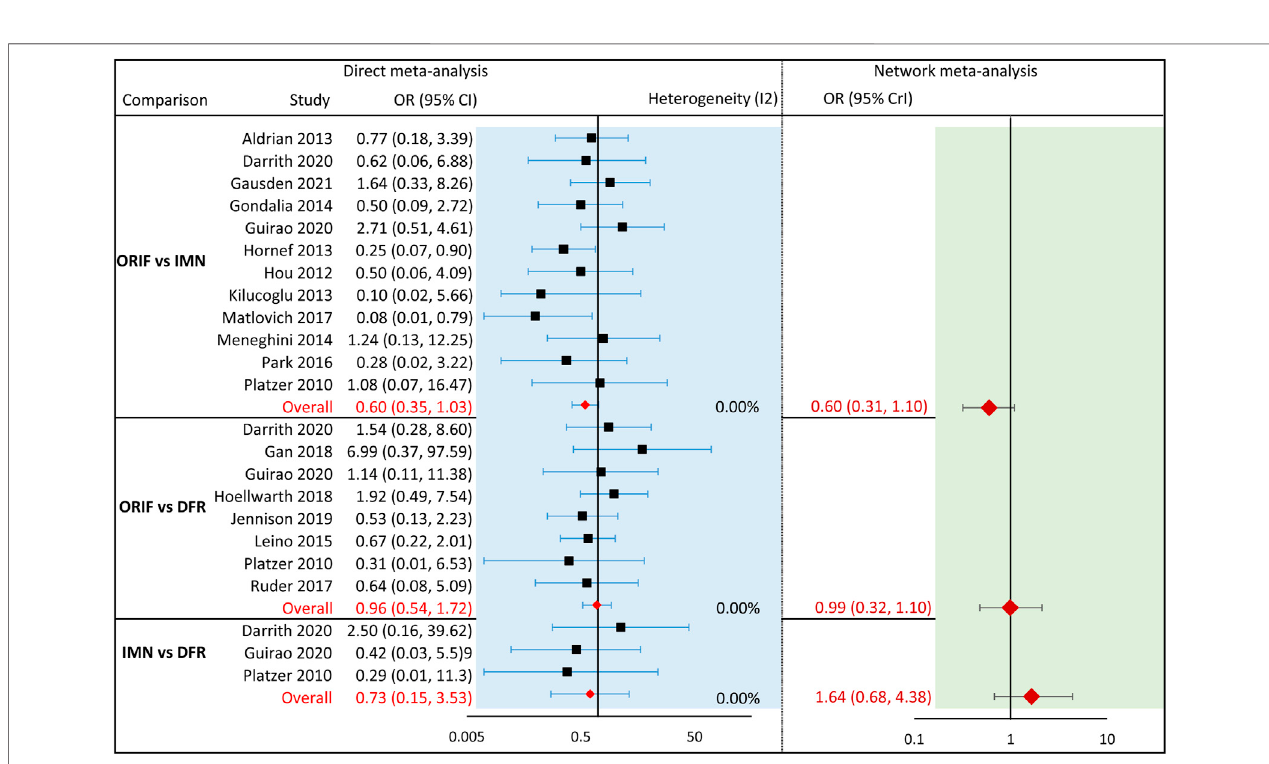
FIGURE 4 | Meta-analysis of the reoperation rate.